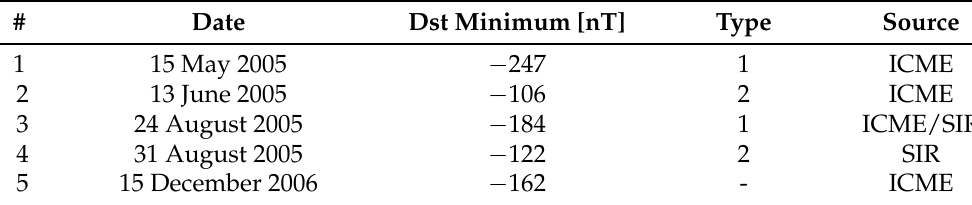
Figure 1. Average particle fluxes obtained during the entire duration of the DEMETER mission are color-coded as a function of energy (ordinate) and L-shell (abscissa) separately for the daytime ( a ) and nighttime ( b ). Table 1. A list of five strong, isolated geomagnetic storms identified during the DEMETER mission analyzed in the present paper. Selection criteria are a Dst index below − 100nT and no other events in a seven-day period around the storm starting one day before the Dst minimum. The minimum Dst value and the type of the storm source are also